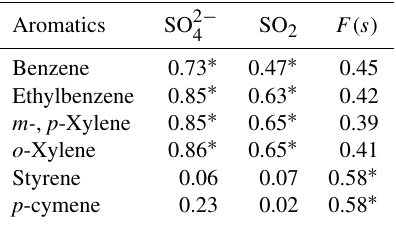
Table A3. Correlation coefficients ( r ) between selected aromatics (at least 15 out of 20 data points are above the detection limit), SO 2 , and sulfate. P values < 0.05 are indicated with a ∗